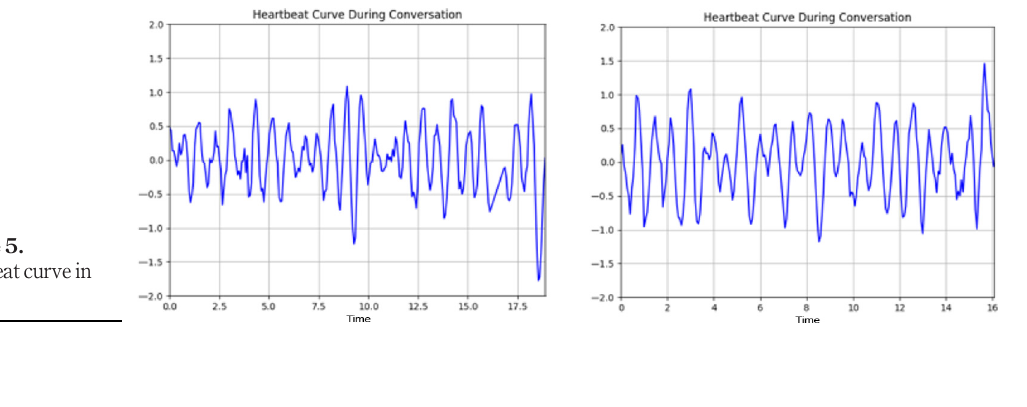
Figure 5. Heartbeat curve in Test 3